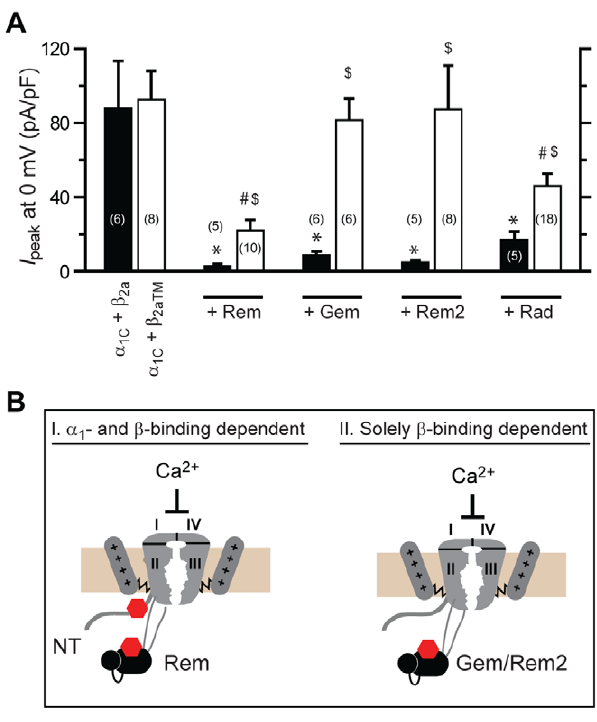
Figure 5. Distinct RGKs differentially use b -binding-dependent and independent mechanisms to inhibit Ca V 1.2 channels. (A) Histogram showing impact of individual RGKs on wild-type ( a 1C + b 2a ) and mutant ( a 1C + b 2aTM ) Ca V 1.2 channels. *, # , $ P , 0.05 when compared to a 1C + b 2a , a 1C + b 2aTM , or a 1C + b 2a + RGK, respectively, using two-tailed unpaired Student’s t test. (B) Cartoon showing dichotomy in the determinants used by distinct RGKs to inhibit Ca V 1.2 channels.